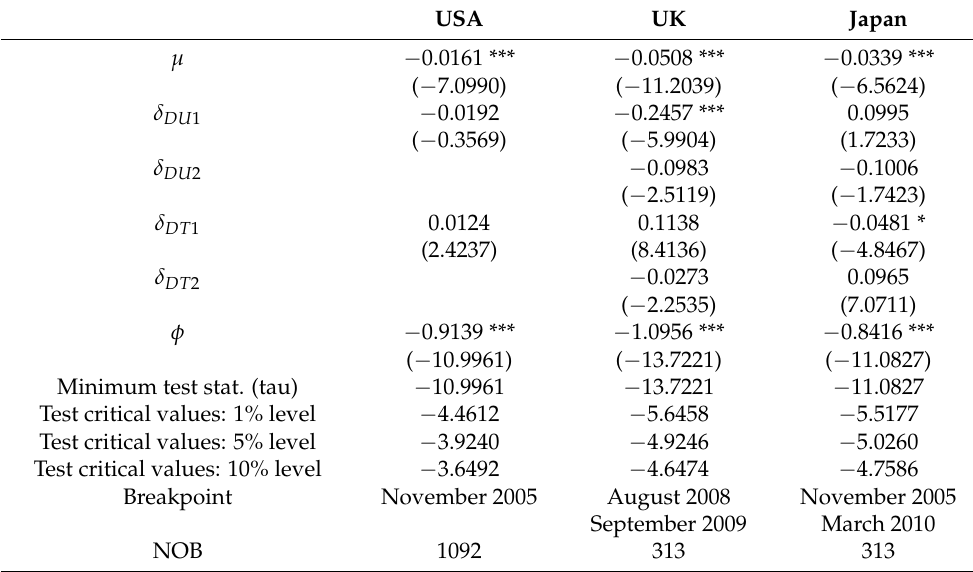
Table 8. Multiple-break unit root tests: Lee and Strazicich test: the break model.